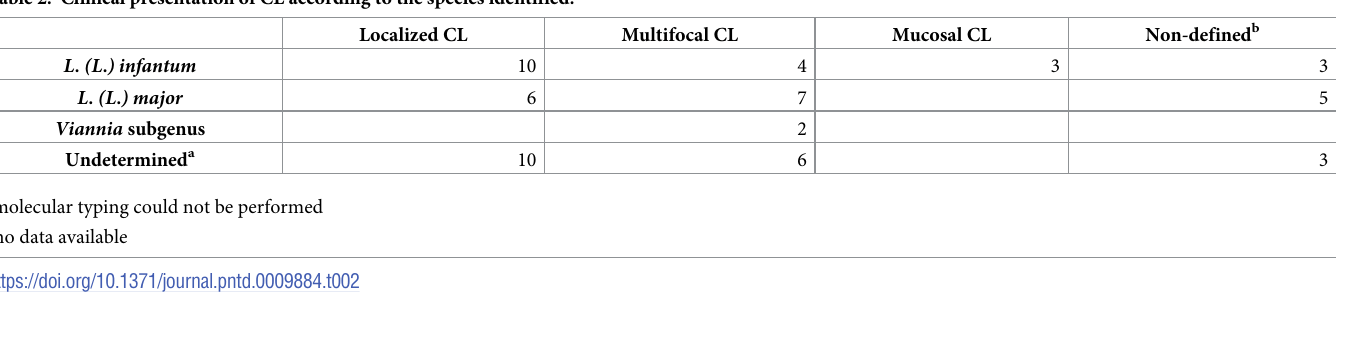
Table 2. Clinical presentation of CL according to the species